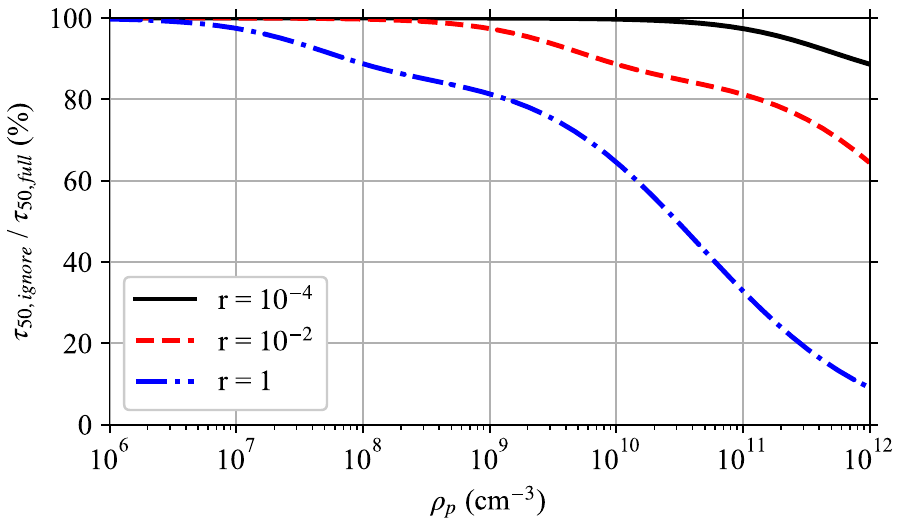
Fig 1. Effect of ignoring multiplicity. Ratio of the time required to reach a 50% infection risk when multiplicity is ignored